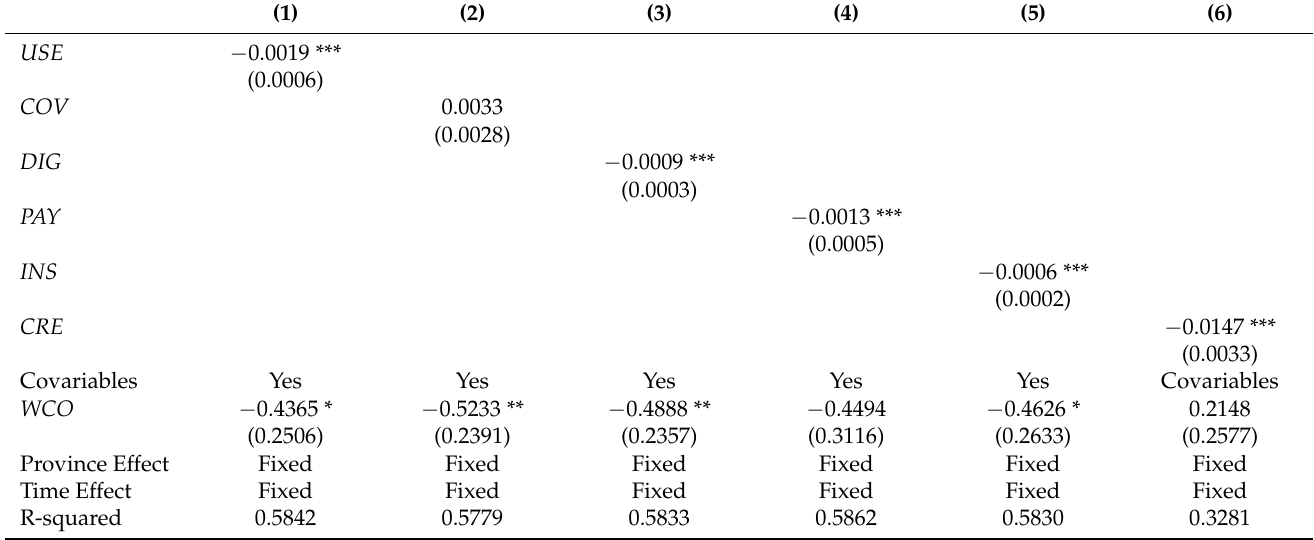
Table 8. Sub-hierarchical indicators